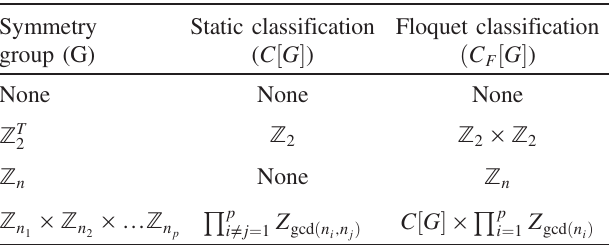
TABLE III. Classification of 1D bosonic Floquet SPTs . — Group structure of nontrivial topological classes for 1D bosonic systems with discrete, Abelian on-site symmetries. Non-Abelian symmetry groups and symmetry groups with antiunitary sym- metries with irreducible representations of dimension larger than one do not permit symmetry-preserving many-body locali- zation and are unstable to heating. The last entry represents the most general finite Abelian symmetry group; a derivation of the Floquet classification for this general case is present